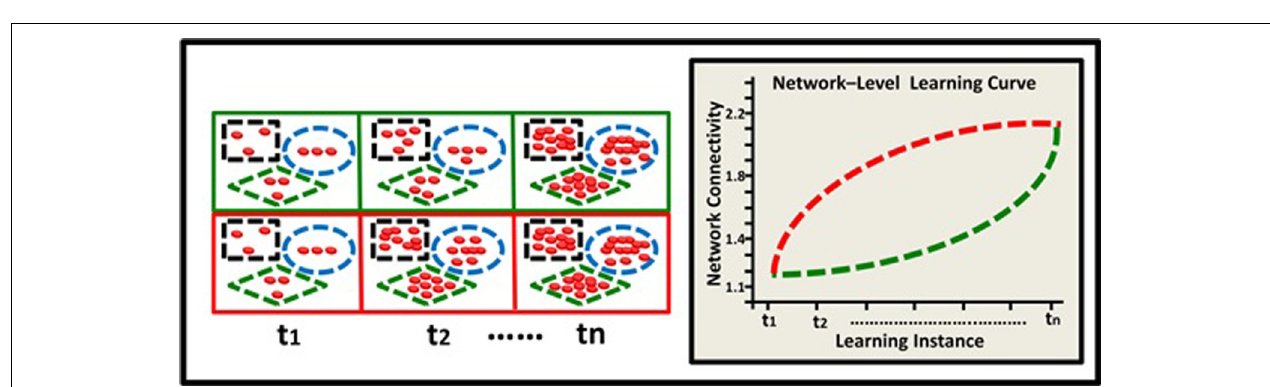
changes in their overall methylation level, their genes’ expression profiles, and eventually their synaptic strength. The black neuron exhibits a diminishing pattern of overall methylation accumulation and a diminishing learning curve (black line) while the blue neuron exhibits a linear pattern of methylation accumulation and a linear learning curve (blue line).